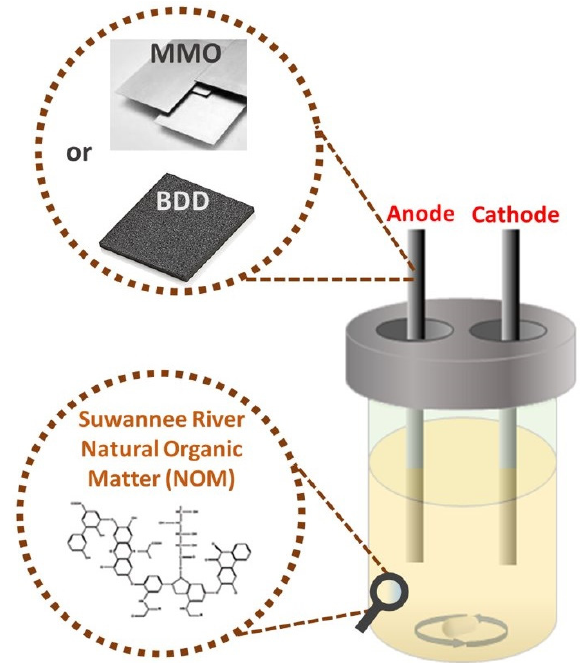
Figure 1. Schematic electrochemical setup containing BDD and MMO electrodes.